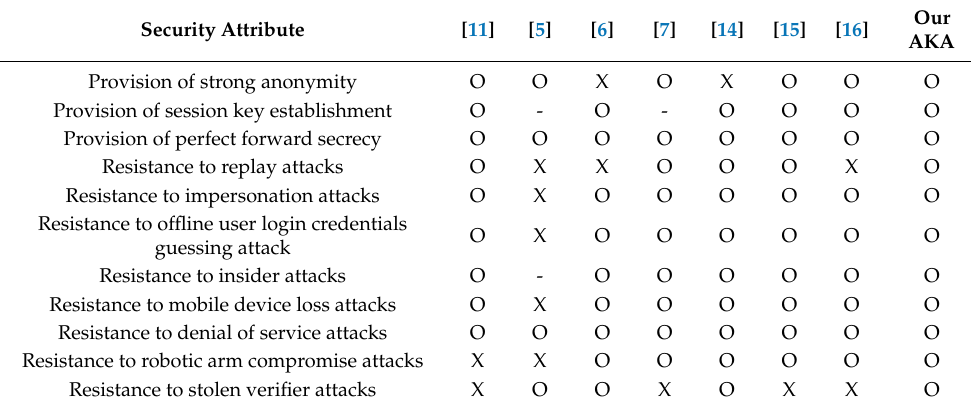
Table 3. Functionality